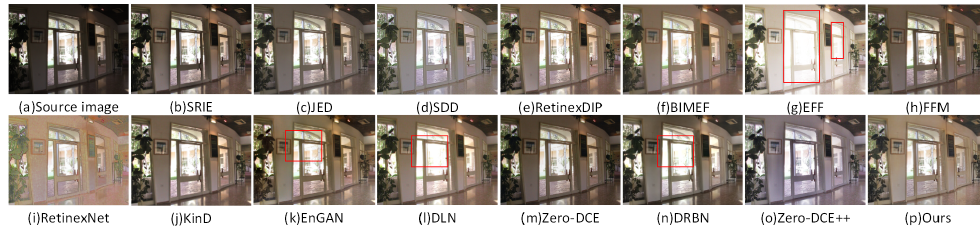
Figure 11. Comparison of the visual effects of the enhanced indoor images in the DICM [35] dataset.